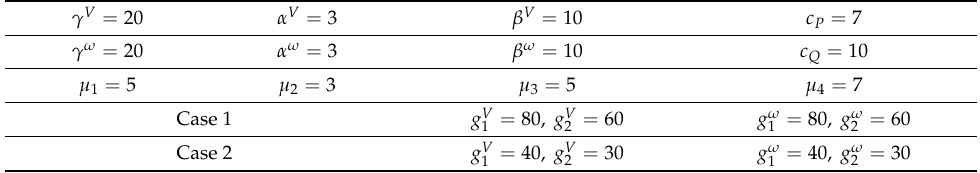
Table 2. Controller gains of proposed algorithm.